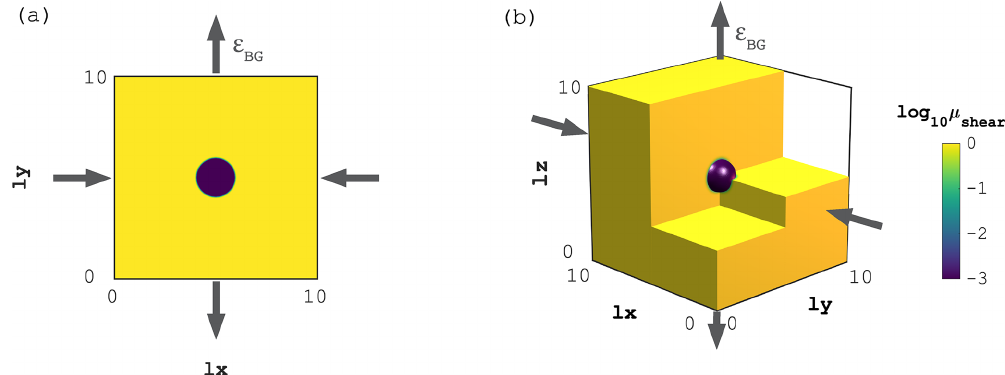
Figure 3. Initial shear viscosity ( µ shear ) distribution for the (a) 2D and (b) 3D visco-elastic Stokes flow configuration, respectively.